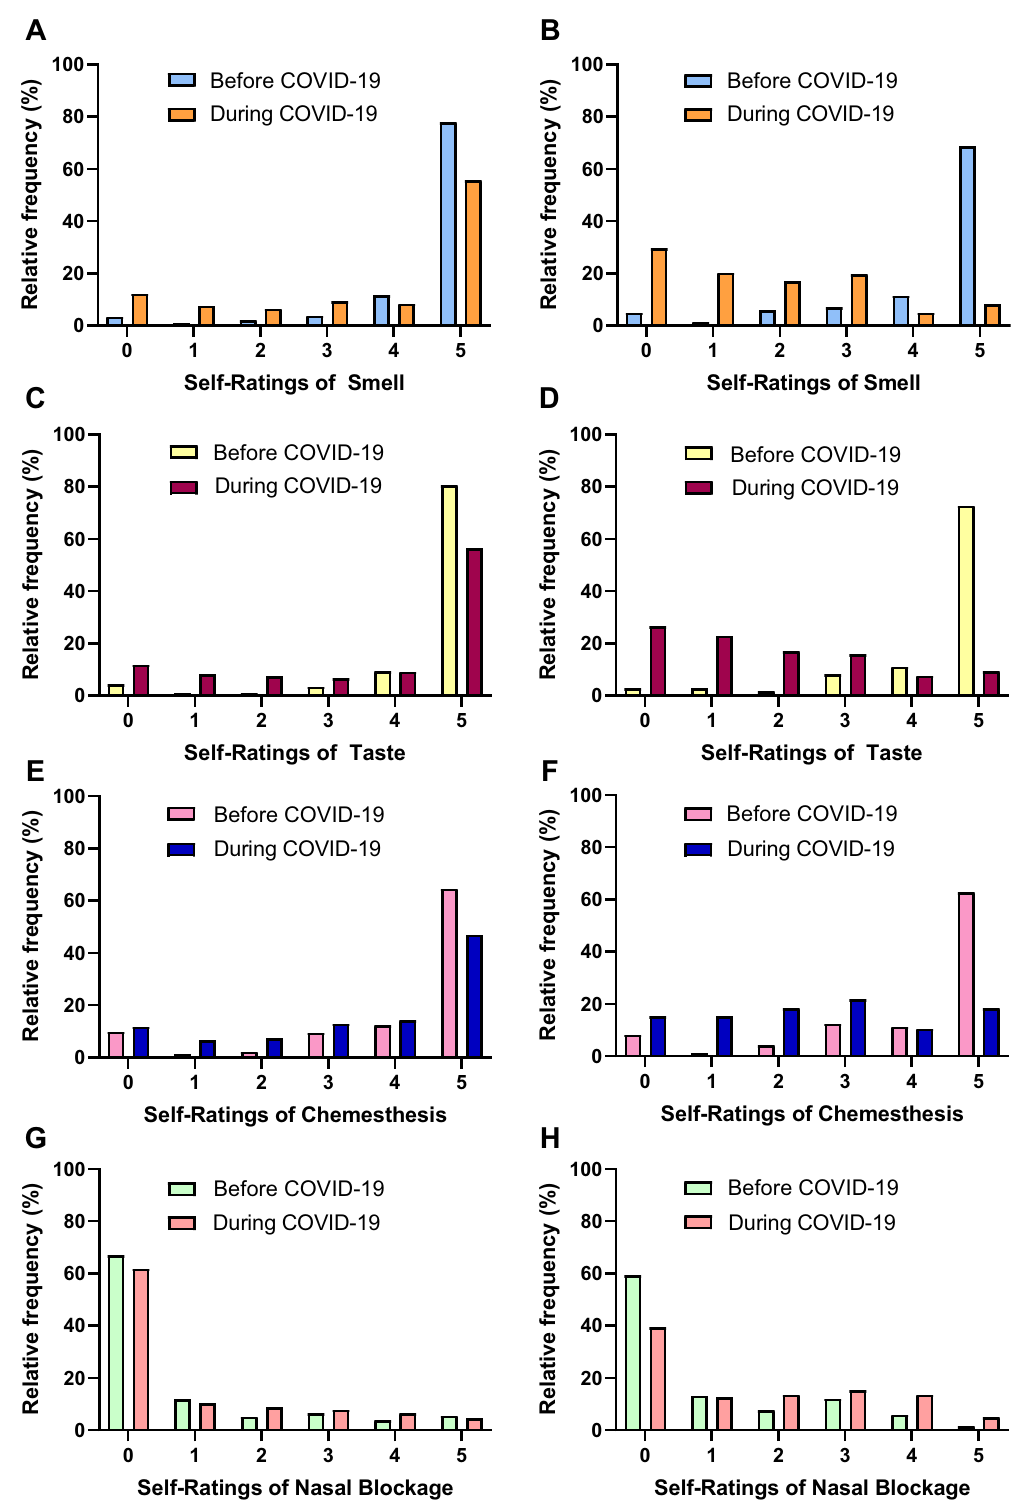
Figure 1. Self-ratings of smell, taste, chemesthesis, and nasal congestion before and during COVID-19. Interleaved histograms represent self-ratings for smell, taste, chemesthesis, and nasal congestion on a 6-point visual analogue scale before and during COVID-19 in all patients ( A , C , E,G ), and the subset of patients who report changes in smell ( B , H ) and taste ( D , F